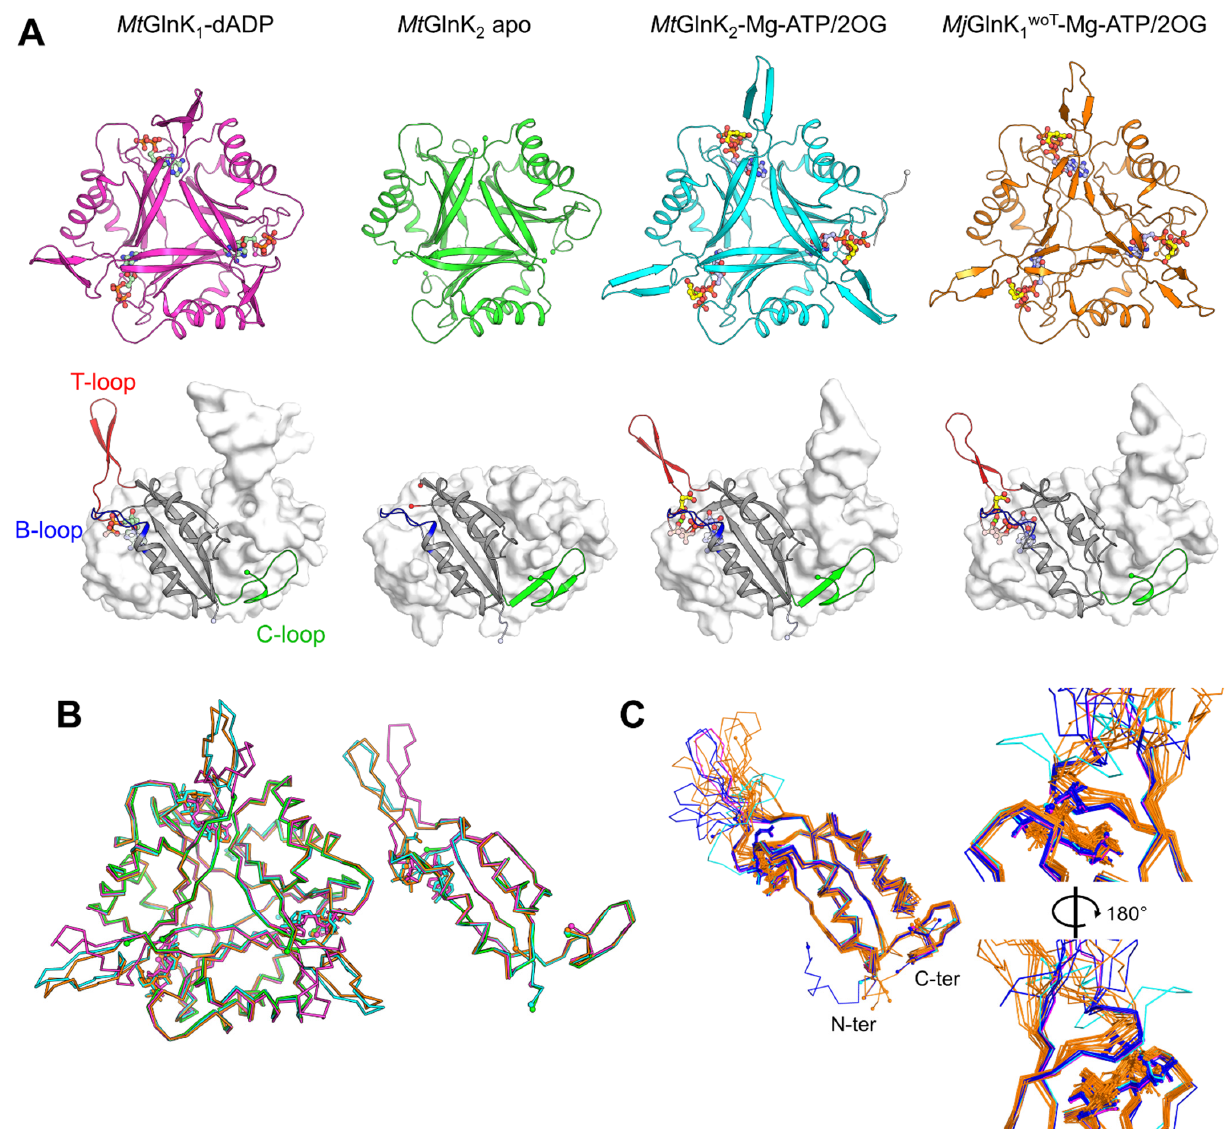
Figure 2. Crystal structures and comparison of the different states of GlnKs from Methanococcales . ( A ) Top row: Trimeric GlnK structures are represented in cartoon with ligands in ball and stick. Bottom row: one chain is in cartoon representation while the two others are displayed as white surface. The T-, B- and C-loops are colored in red, blue and green, respectively. Carbon atoms are colored in yellow for 2OG, in pale green for dADP, in pale blue for ATP while nitrogen, oxygen, phosphorus and Mg are colored in blue, red, orange and green, respectively. The N-terminal tag of Mt GlnK 2 -Mg-ATP/2OG is colored in light grey and belongs to the symmetry mate. N- and C-termini as well as the cut in the T-loop are shown with spheres. ( B ) Superposition of all obtained structures as trimer ( left ) and monomer ( right ) in ribbon and stick representation. Chains and atoms are colored according to panel A top. ( C ) Superposition of all available P II structures containing ADP or Mg-ATP/2OG are shown in ribbon with ligands in sticks (see Figure S5 for more details). Structures with ADP are colored in orange, structures with Mg-ATP/2OG in blue, Mj GlnK 1 -Mg-ATP/2OG with tag (2J9E) in cyan and Mj GlnK 1woT -Mg- ATP/2OG in pink. Overall view of the monomer ( left panel ) and close-up of the ligand binding site ( right